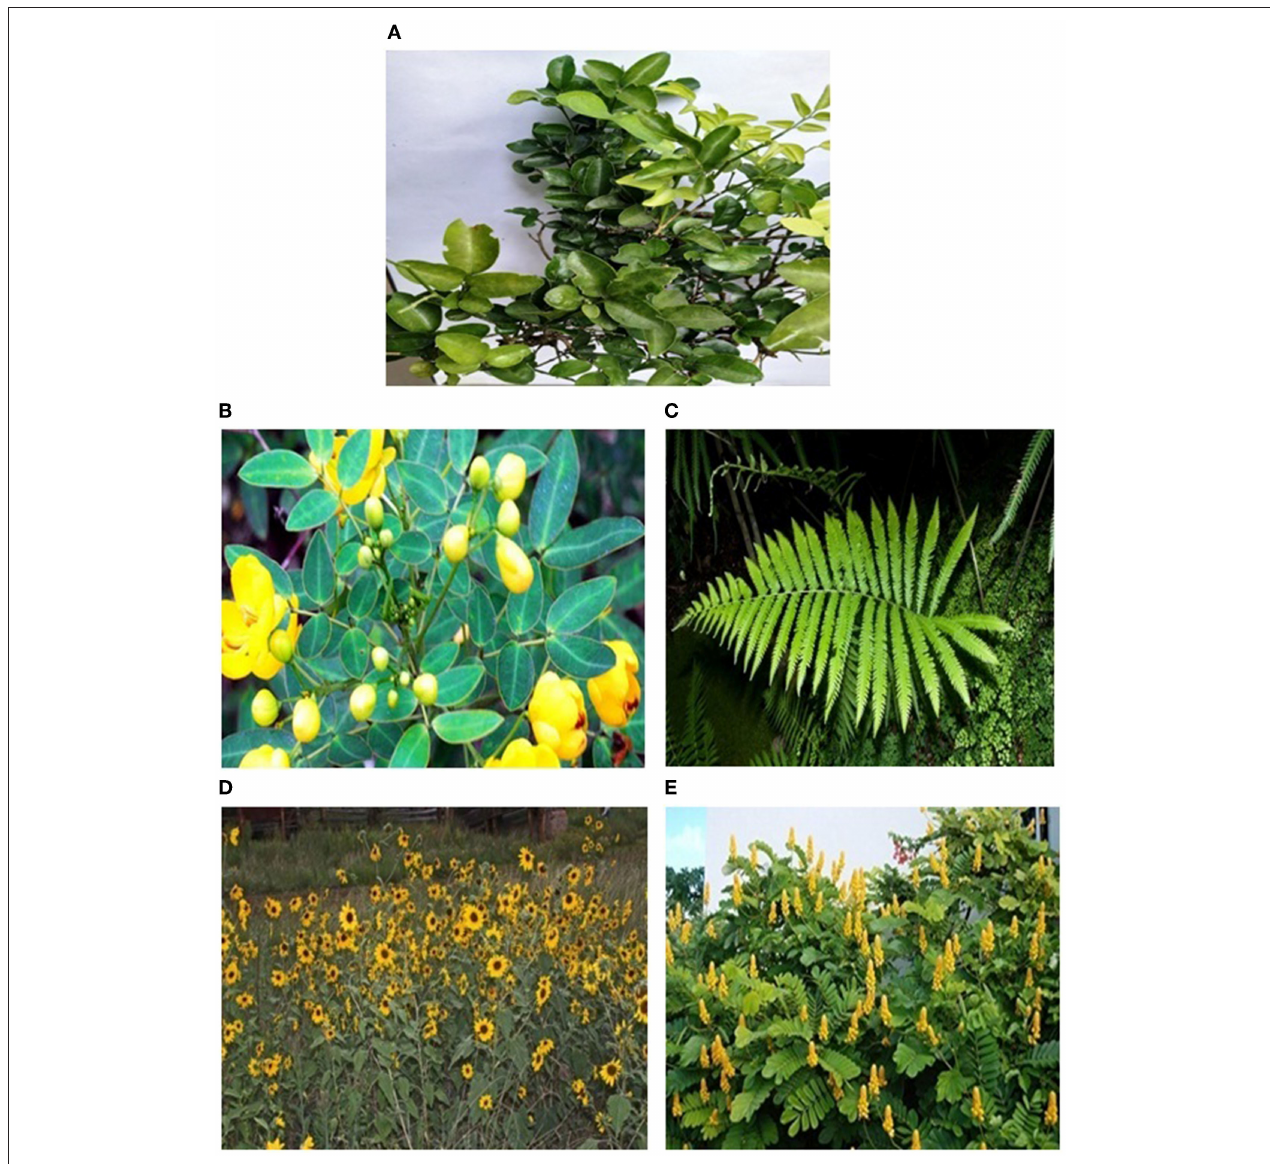
FIGURE 2 | Pesticidal plants evaluated against tea red spider mite. (A) M. paniculata, (B) C. tora , (C) A. opulentum , (D) T. diversifolia , and (E) C. alata (source: North Bengal Regional R and D Centre, Tea Research Association, West Bengal, India).